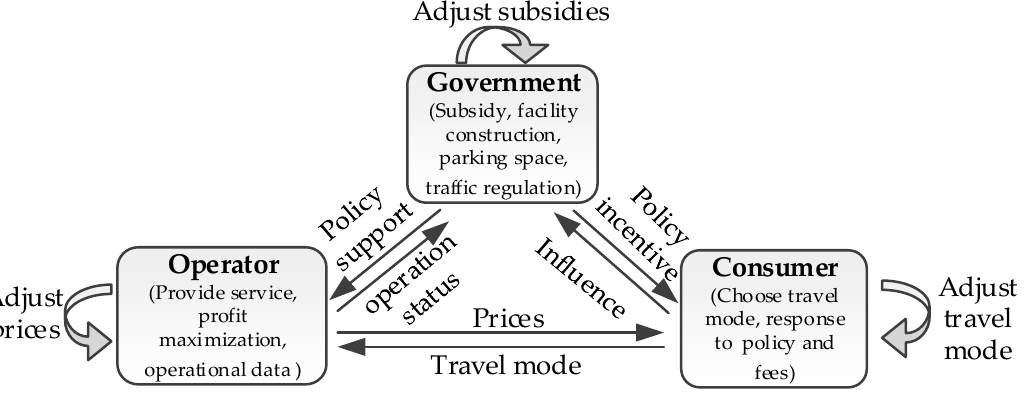
Figure 1. Relationships among the participants of electric vehicle sharing.